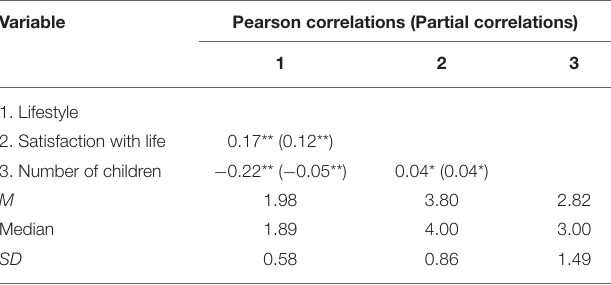
TABLE 2 | Pearson and partial correlations.